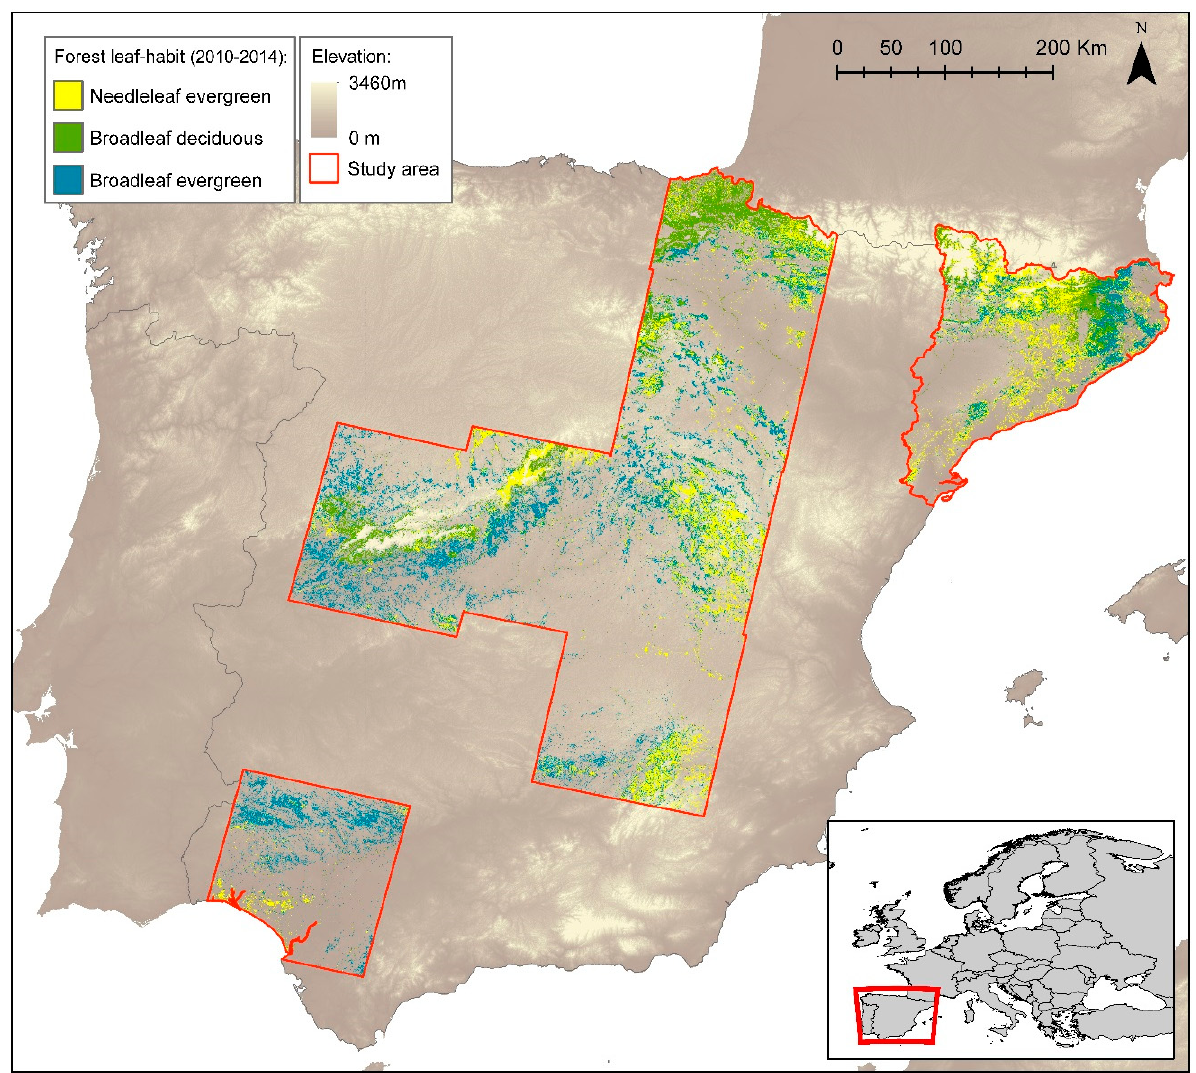
Figure 1. Secondary forest distribution during 2010–2014 by the main forest leaf-habit types in the Iberian Peninsula.